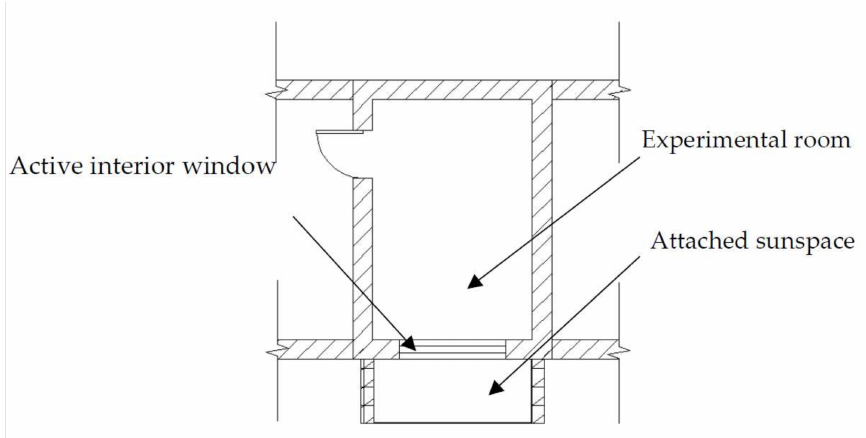
Figure 2. Structural schematic of the living lab.